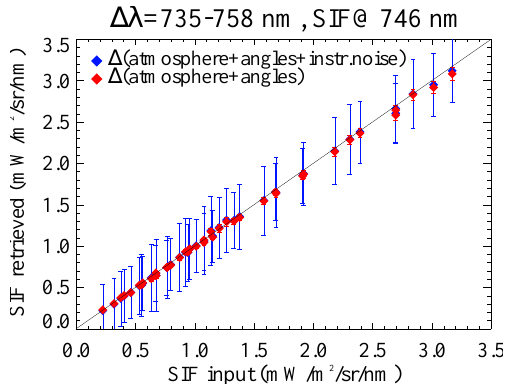
tematic errors such as radiometric offsets or stray light are 485 neglected.